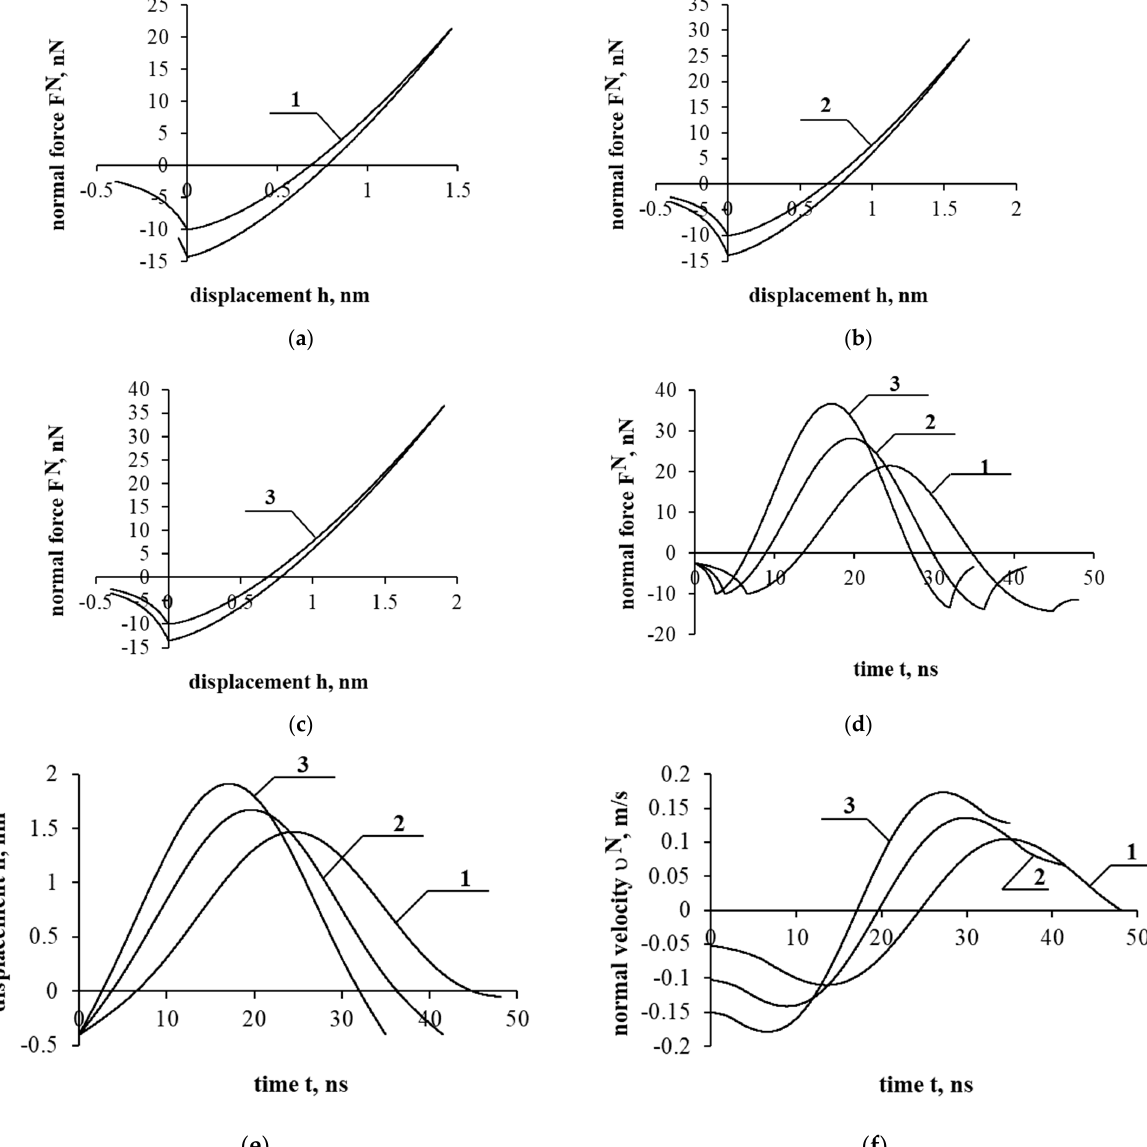
Figure 7. Normal interaction. Particle impact at various impact angles: 1— ϕ 0,1 = 10 ◦ ; 2— ϕ 0,2 = 20 ◦ ; 3— ϕ 0,3 = 30 ◦ . Normal force versus displacement ( a – c ); normal force ( d ); normal displacement ( e ); normal velocity history ( f ).